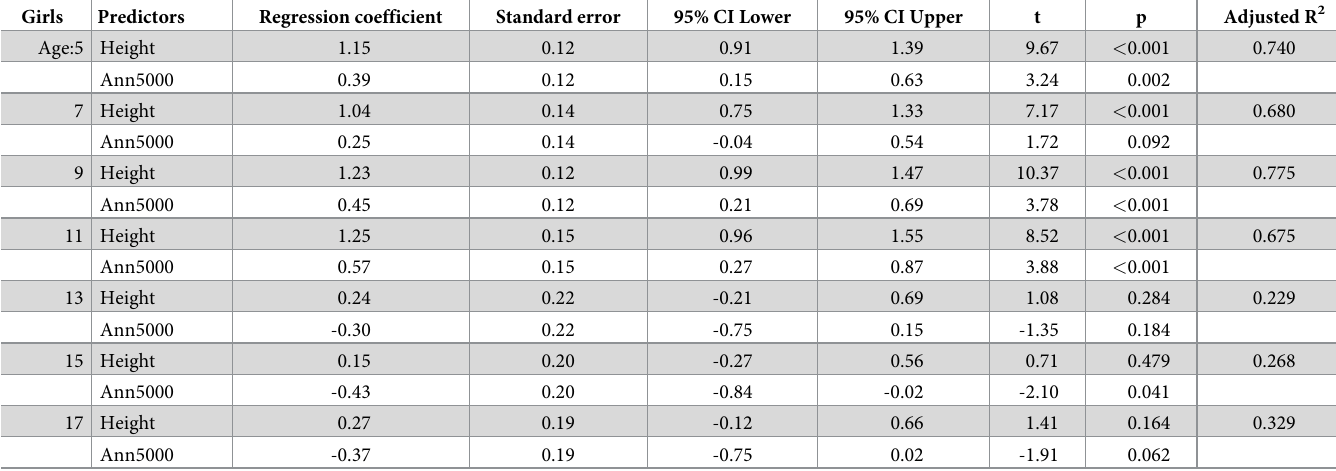
Table 7. Regression coefficients (standard errors) of predictors of weight